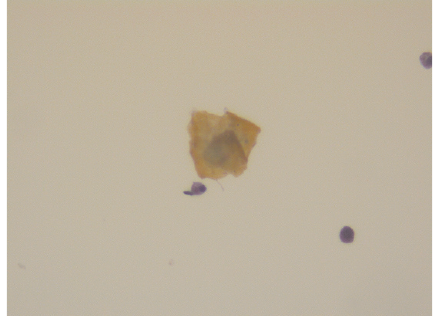
Figure 9: Pap stain: scattered anucleate squame in peritoneal